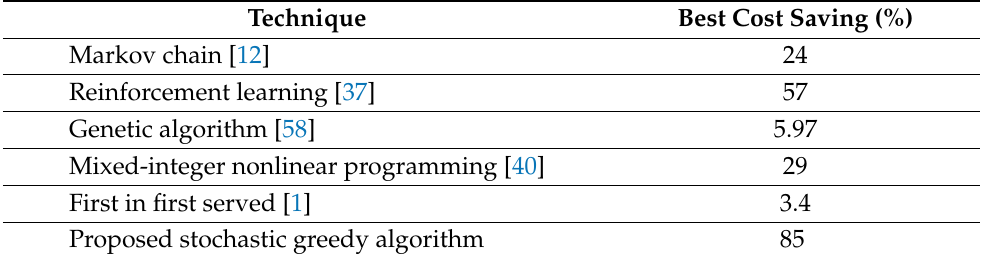
Table 6. Effectiveness of the previous schedulers for the V2G